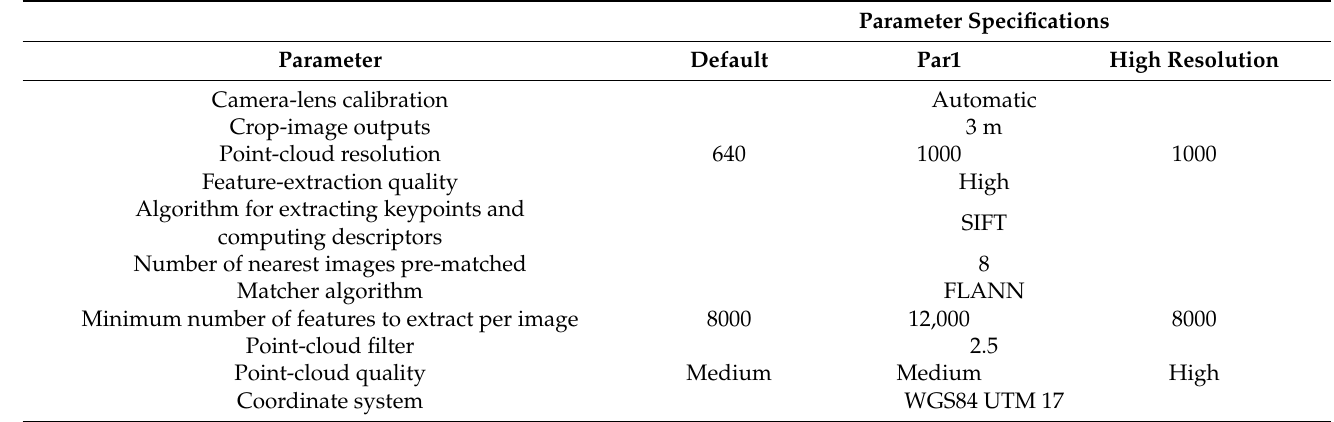
Table 1. Processing parameters used in Web Open Drone